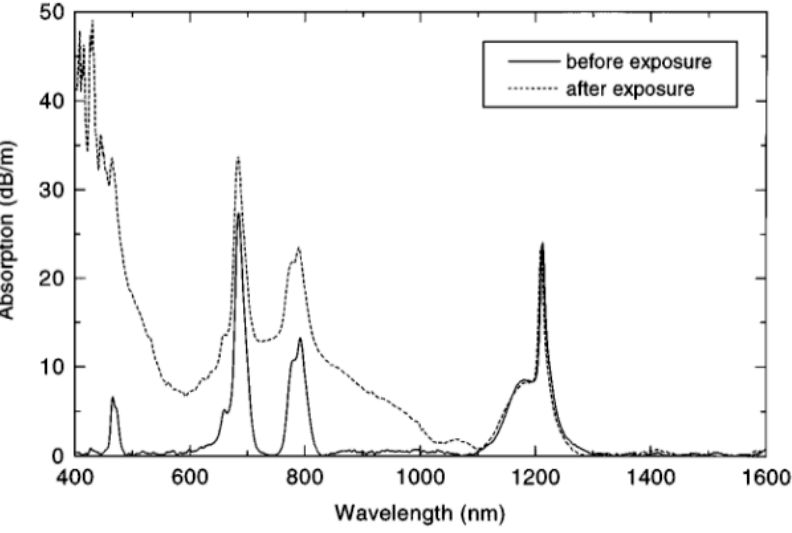
Figure 4. Absorption spectra of fiber C before and after exposure to 200 mW of power at 1.12 µ m for 120 s. Adapted with permission from [4] © The Optical Society.